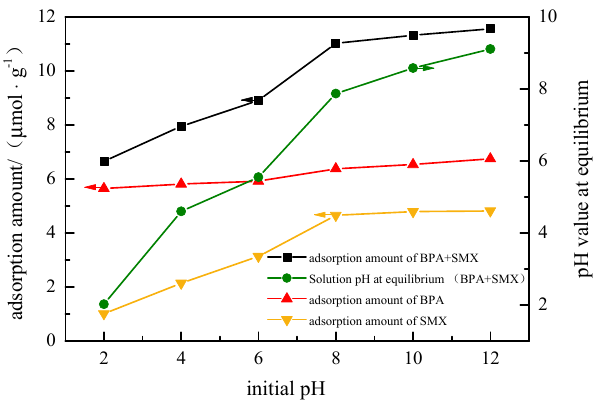
Figure 3. Effect of initial pH of solution on adsorption performance.